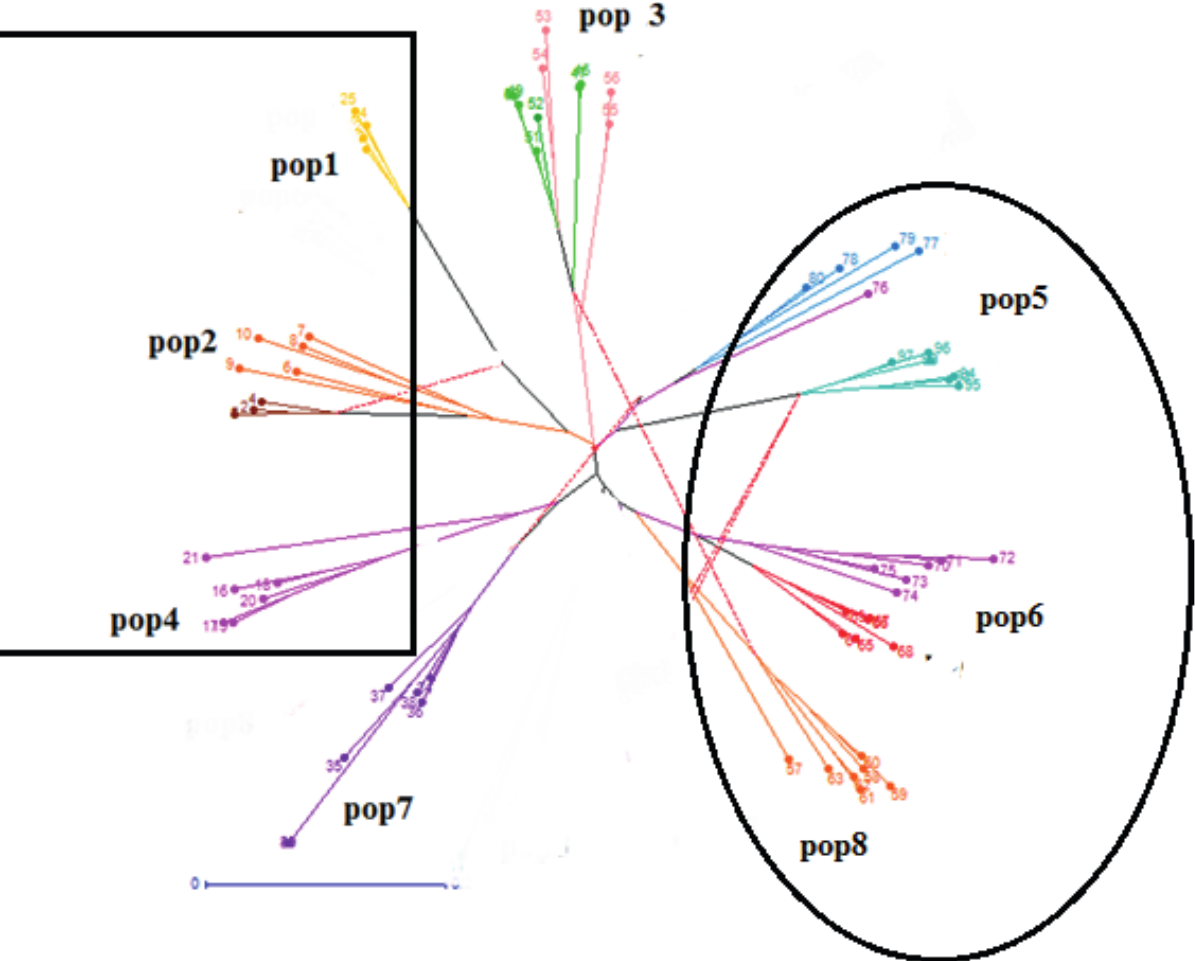
Figure 4. Reticulogram of Salicornia persica populations based on least squares method analysis of ISSR data (Population numbers accord- ing to Table